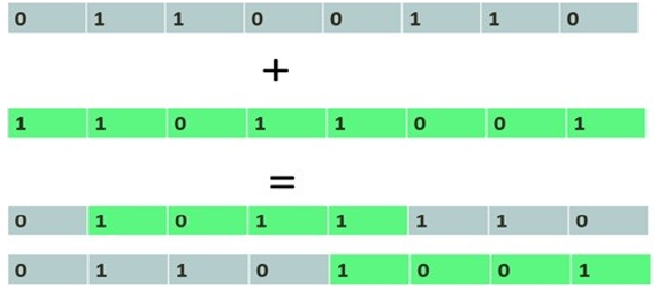
Figure A1. CrossOver